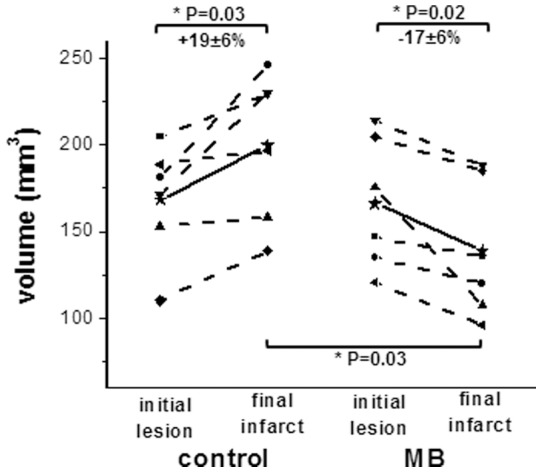
Initial lesion (30 mins) and final infarct (day 2) volumes of vehicle- and MB-treated rats subjected to 60 mins MCAO.Initial lesion and final infarct volumes of individual animal were connected using dot lines. Mean initial lesion and final infarct were connected using solid lines.